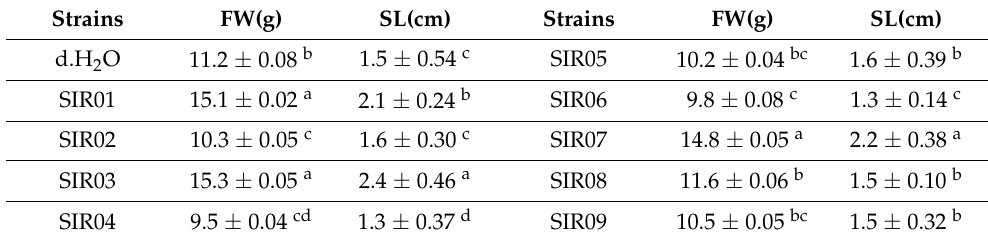
Table 1. Screening bioassay of nine bacterial strains for growth promoting activity in sesame